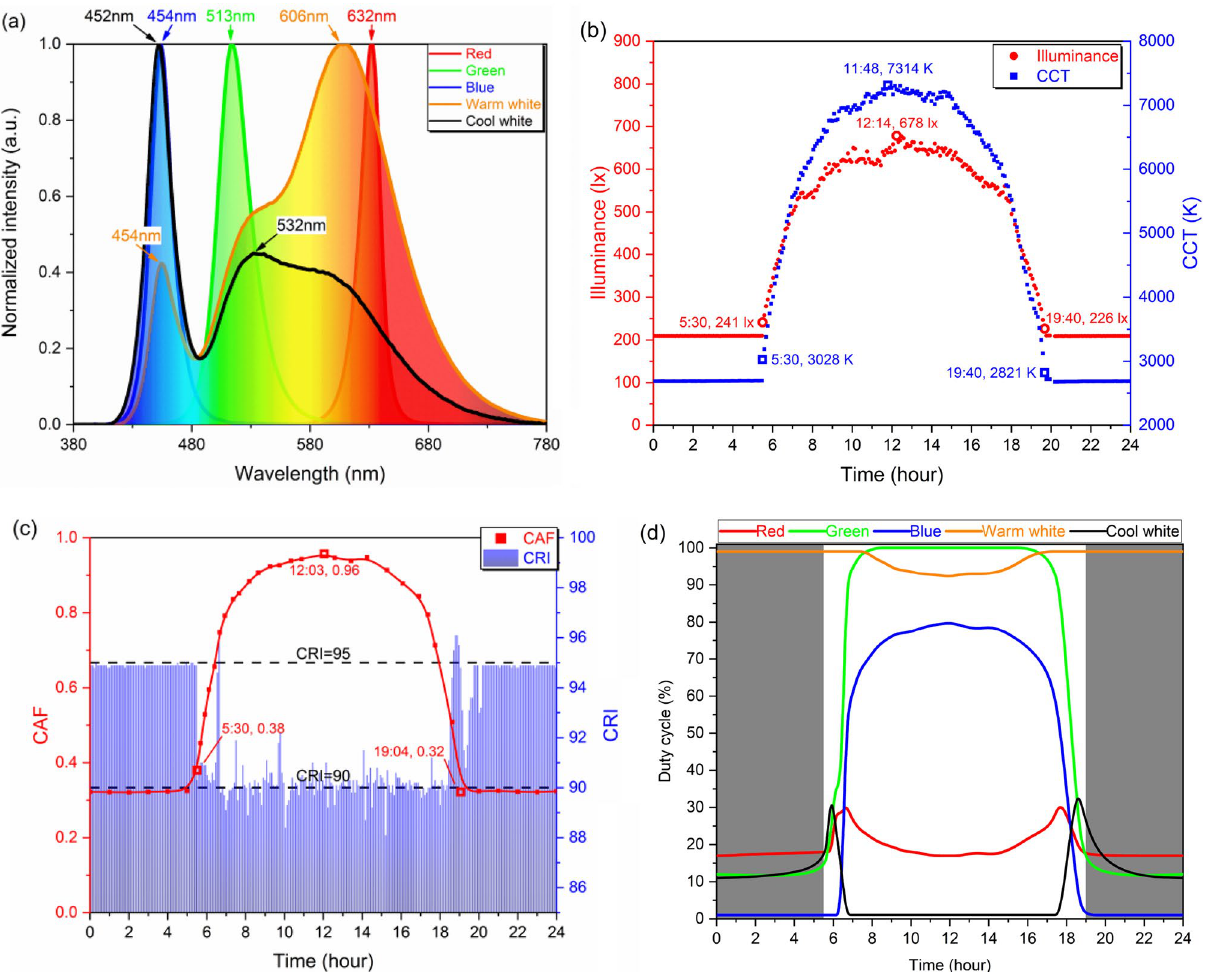
Figure 6. Parameters of the RGBWW LEDs and light environment. ( a ) The normalized SPDs of red, green, blue, warm white, and cool white LEDs. ( b ) Illuminance and CCT, ( c ) CAF and CRI of the light environment throughout the day. ( d ) Time-dependent duty cycles of five channels throughout the day. (The figure was generated by Origin 2018, URL: https:// www. origi nlab. com/).